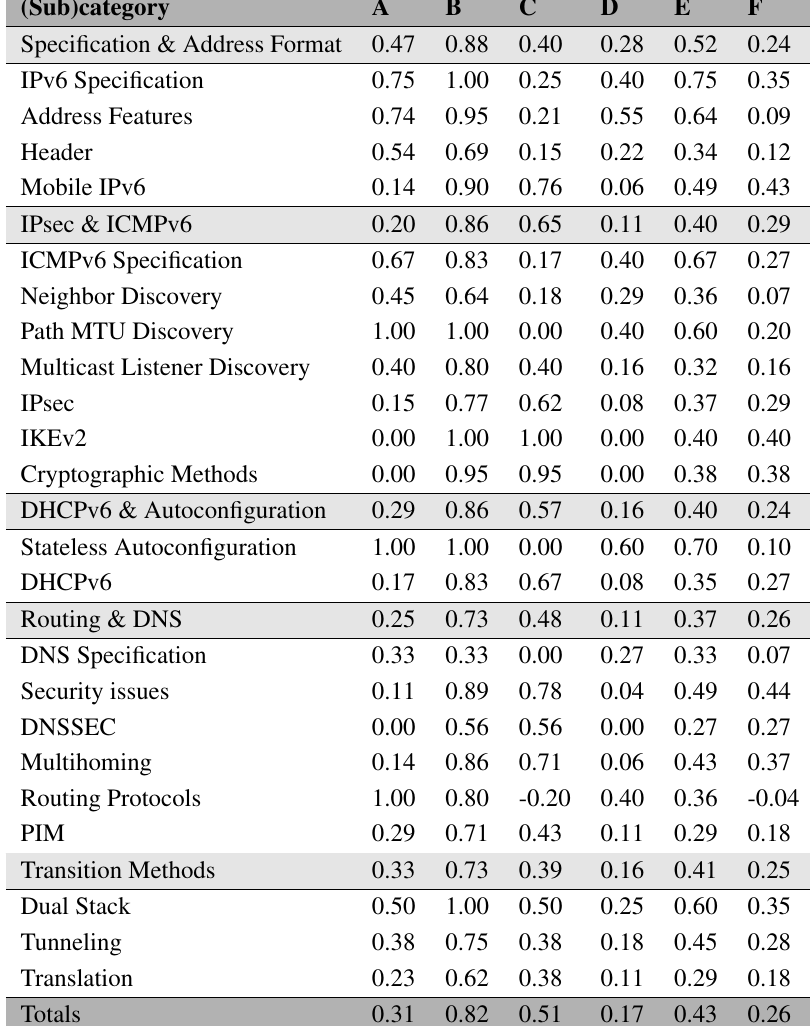
Table 8. Comparison of BSI and NIST. Columns: A = BSI completeness; B = NIST completeness; C = Completeness difference (B − A); D = BSI depth; E = NIST depth; F = Depth difference (E −